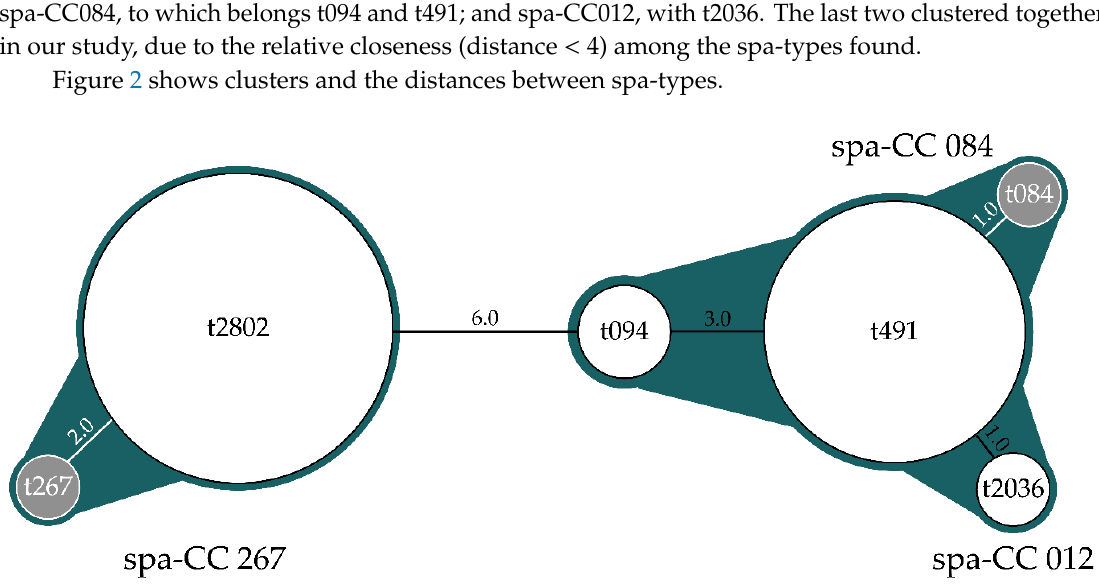
Figure 2. Relationship between clones: clusters are highlighted in blue, with spa ‐ CCs notations. Each circle’s size is proportional to spa ‐ type frequencies and distance between them is reported. Spa ‐ CCs in grey are the founders of the clonal complexes. Distances between spa ‐ types were analyzed by based upon repeated pattern (BURP) algorithm.